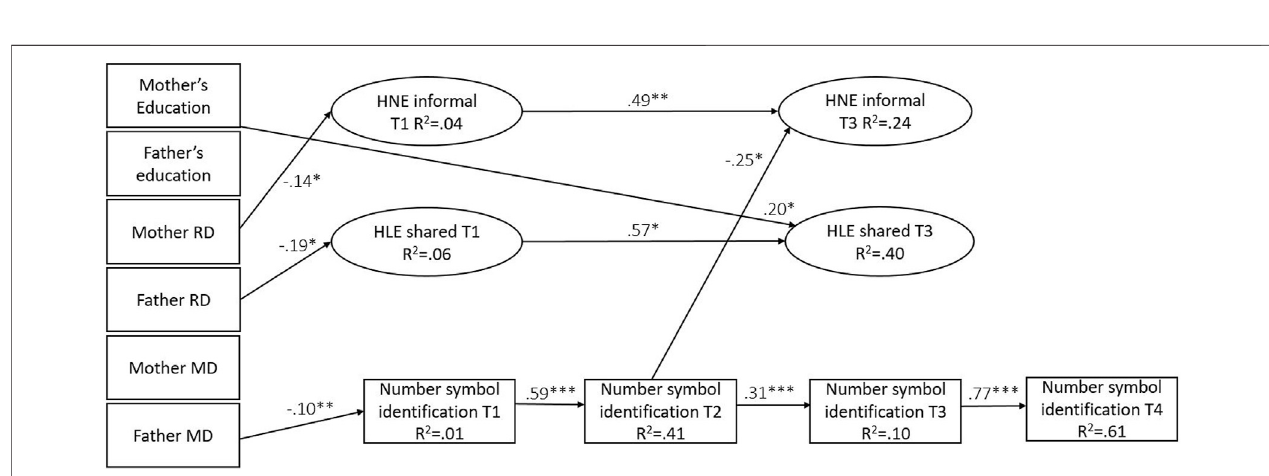
FIGURE 7 | The model for number symbol identi fi cation with the signi fi cant standardized estimates. Note: In addition to the regression paths depicted, there was one signi fi cant residual correlation: between HNE and HLE at T1 (stand. estimate (cid:1)